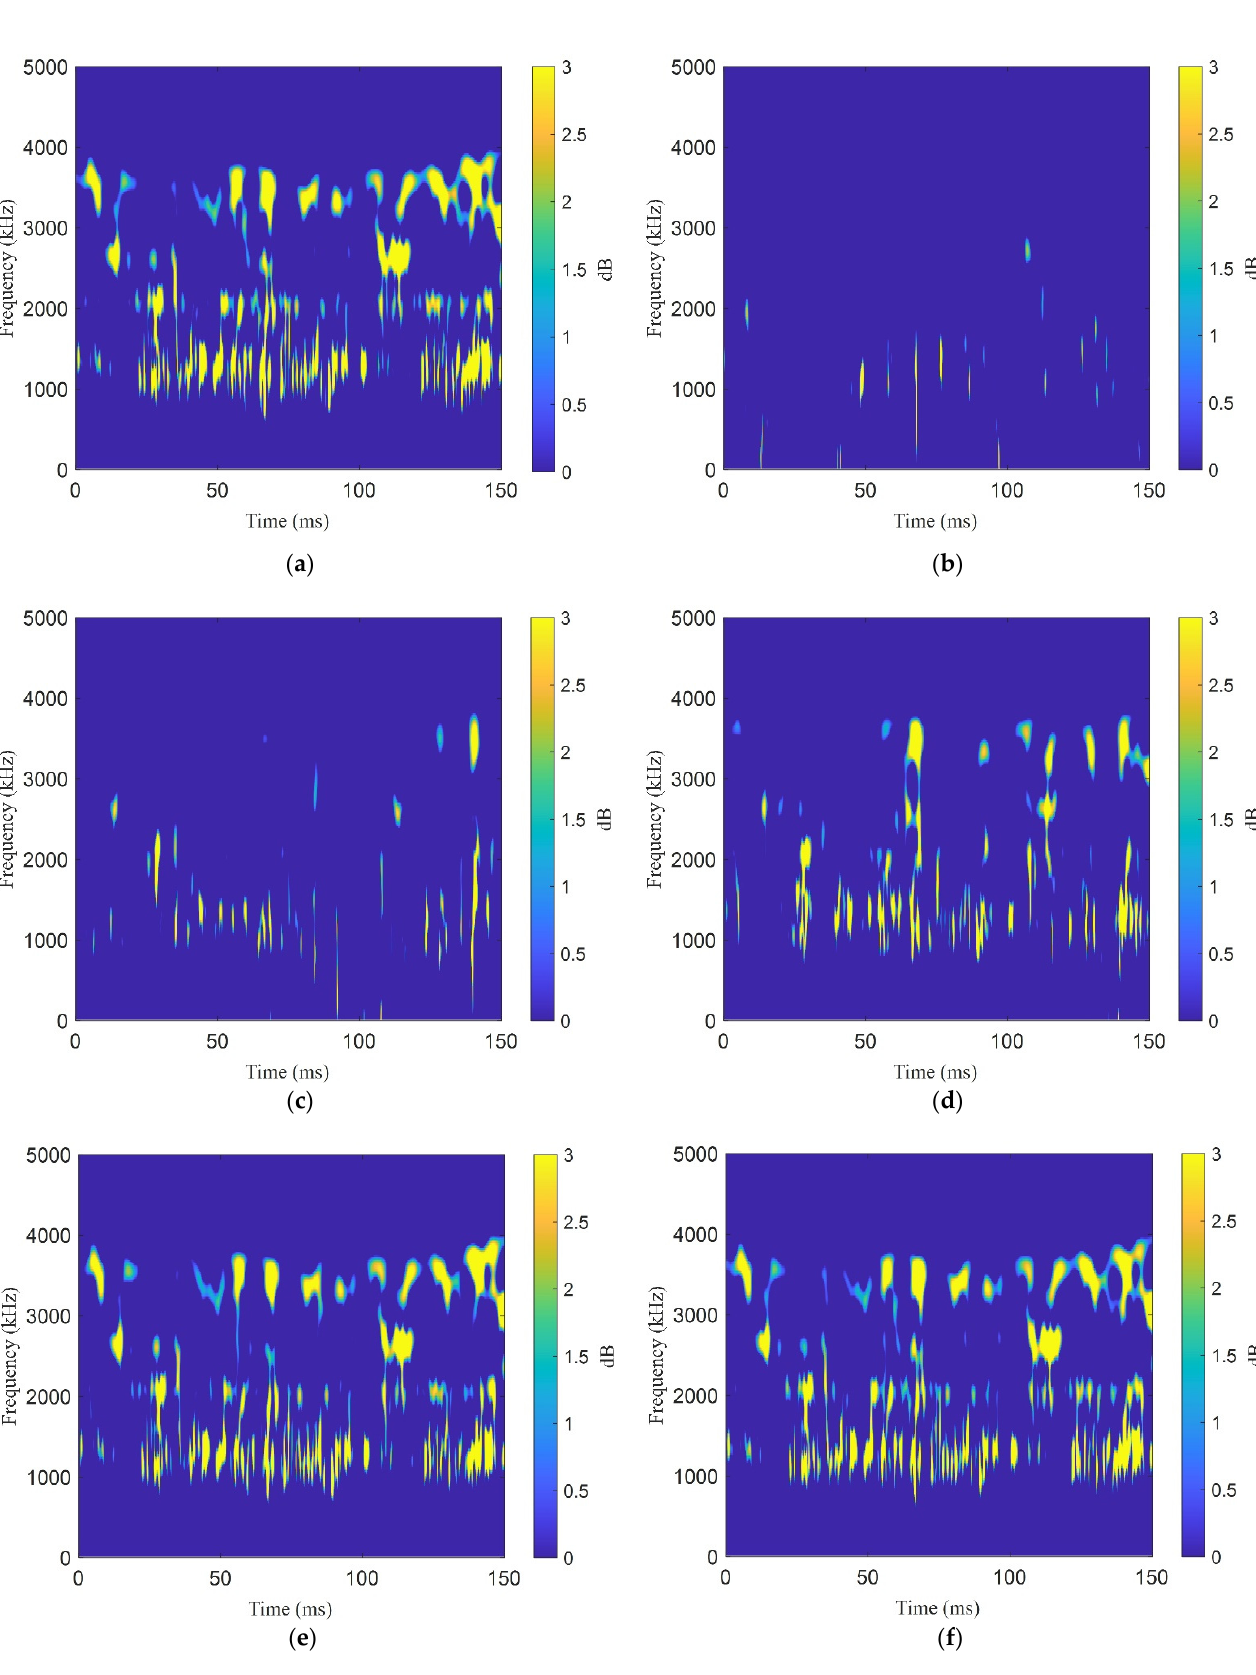
Figure 11. Schematic diagram of wavelet transform of sun gear fault under different compression ratios: ( a ) original signal; ( b ) CR = 0.8; ( c ) CR = 0.7; ( d ) CR = 0.6; ( e ) CR = 0.5; ( f ) CR = 0.4.